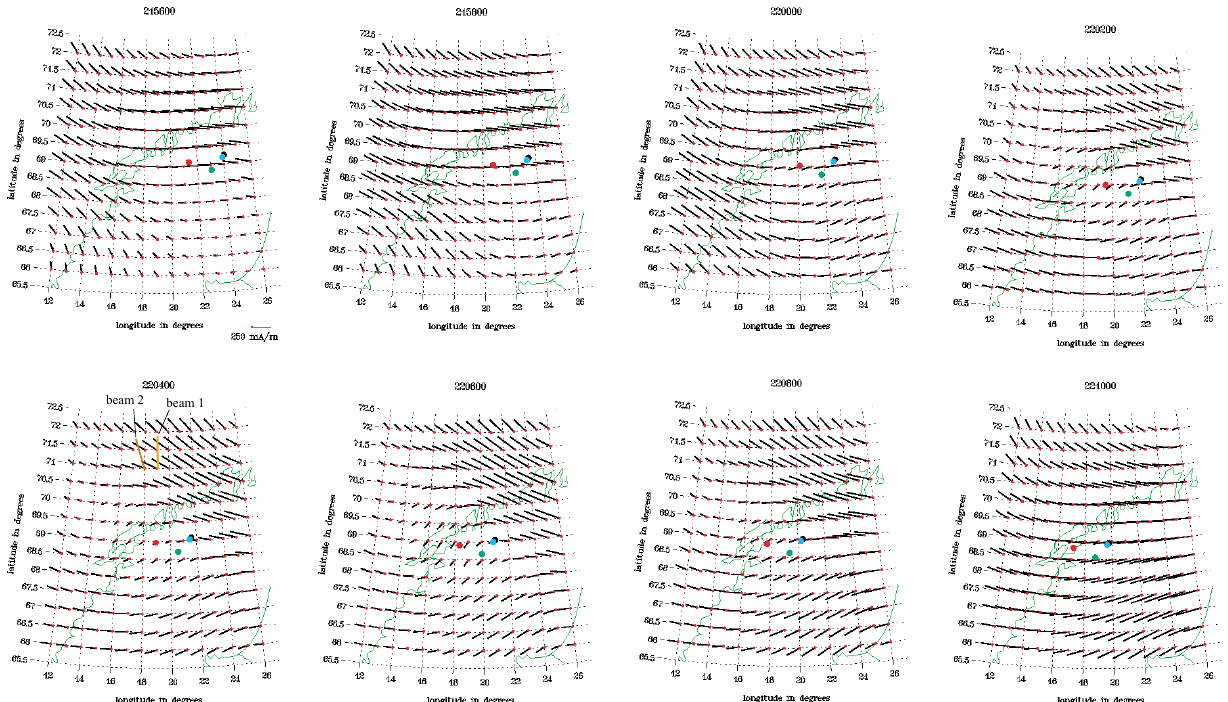
Fig. 8. Equivalent current pattern using full 2-D set of IMAGE magnetometer based on the 2-D magnetic field continuation technique to the ionosphere for every 2min between 21:56 and 22:10 UT. Cluster footpoint is also shown in each